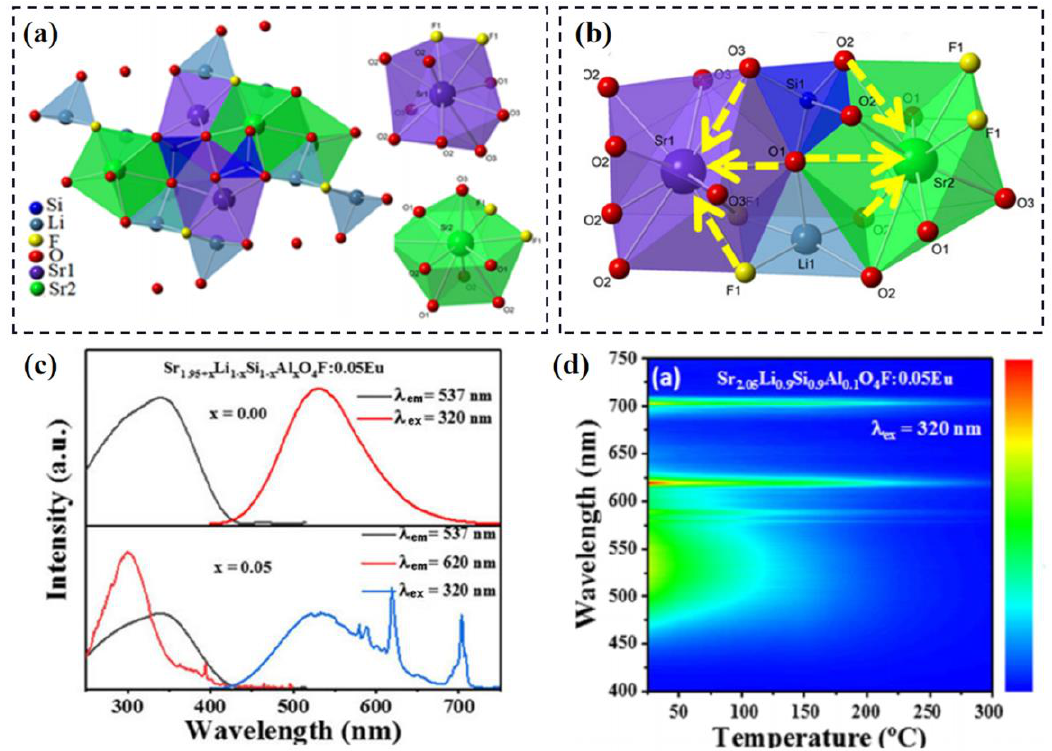
Figure 7. ( a ) Crystal structure of Sr 2 LiSiO 4 F. ( b ) Schematic diagram of the local structure change of Sr site. ( c ) PLE and PL spectra of Sr 1.95+x Li 1 − x Si 1 − x Al x O 4 F:0.05Eu (x = 0 and 0.05). ( d ) Temperature-dependent PL spectra of Sr 1.95+x Li 1 − x Si 1 − x Al x O 4 F:0.05Eu (x = 0.10). Reprinted with permission from ref.